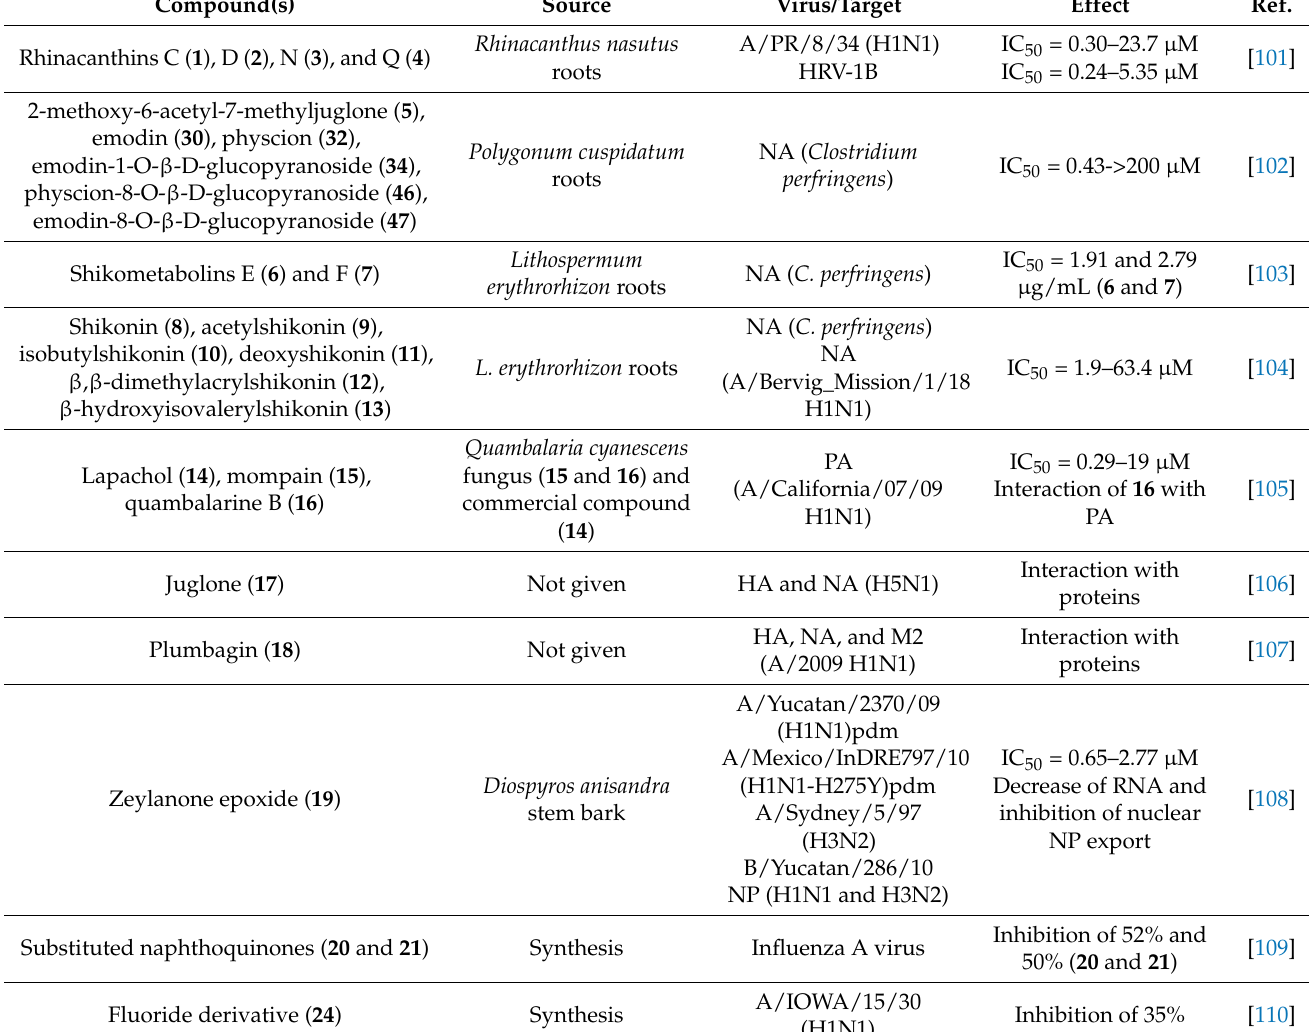
Table 1. Quinones with activity against respiratory viruses and their protein viral